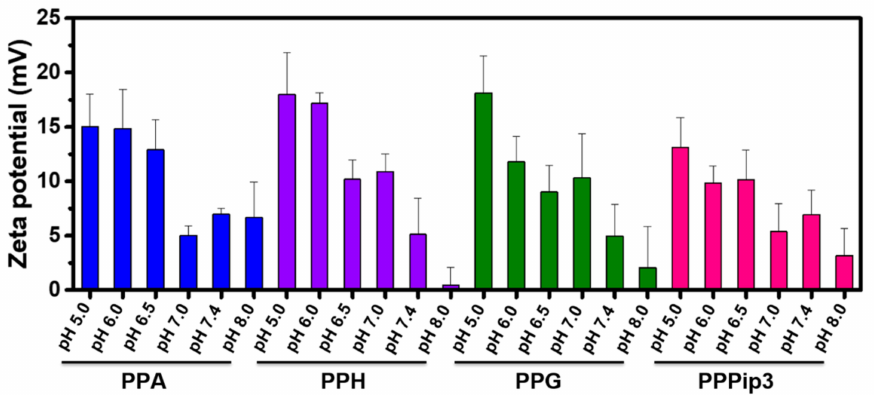
Figure 5. Zeta potential of PPA-SPDP variants at different pHs. For the zeta measurement, 1 mg/mL sample was taken, and the pH was adjusted before measurement. The error bars represent means ± SD of five